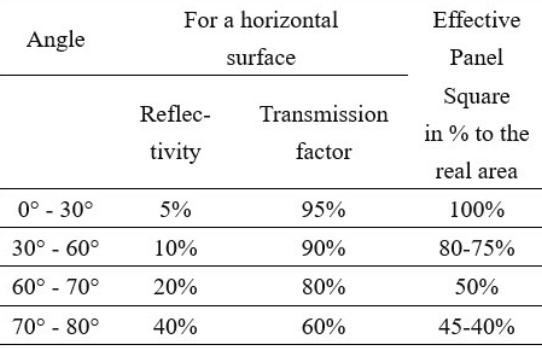
Table 1. Ratio of reflection